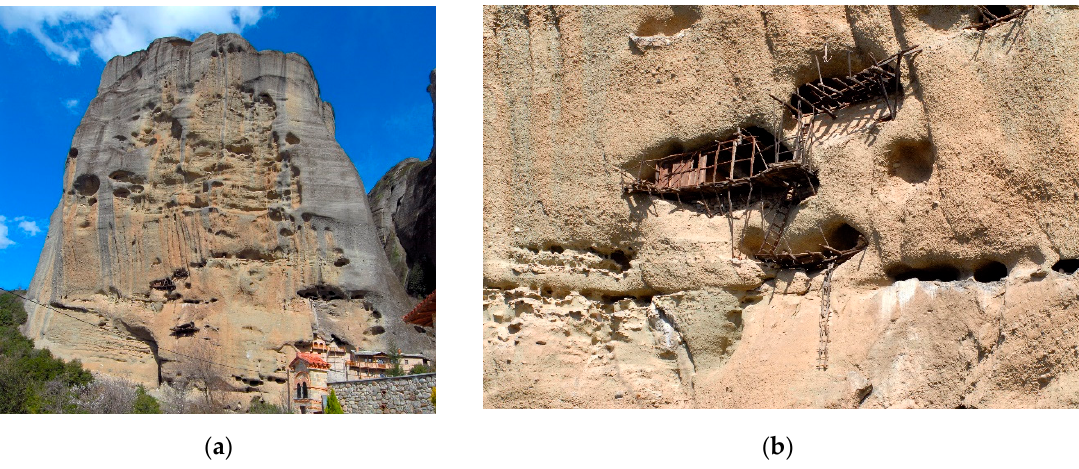
Figure 5. ( a ) View of the rock of Pixari ( b ) The skete of Pixari with the three hermitages of St. Gregory and the characteristic wooden balconies and ladders.